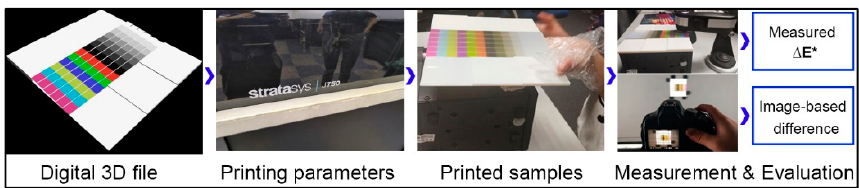
Figure 6. The flowchart of our experiment.